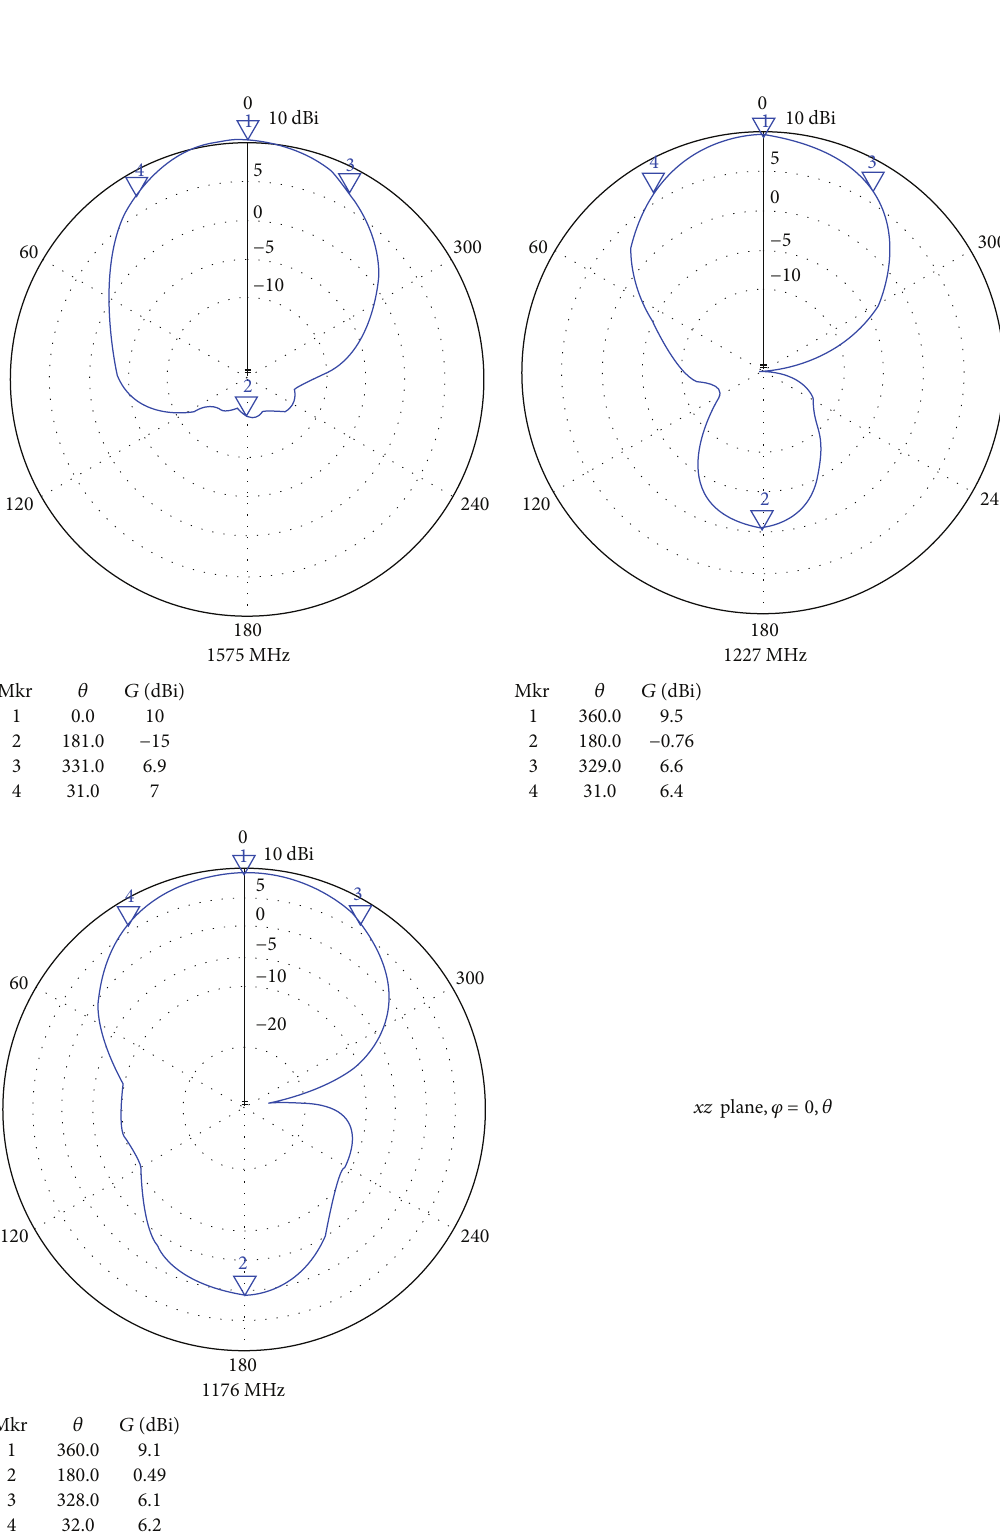
Figure 10: Radiation patterns at 𝑥𝑧 plane for the helical antenna above ground plate at 1575 MHz, 1227 MHz, and